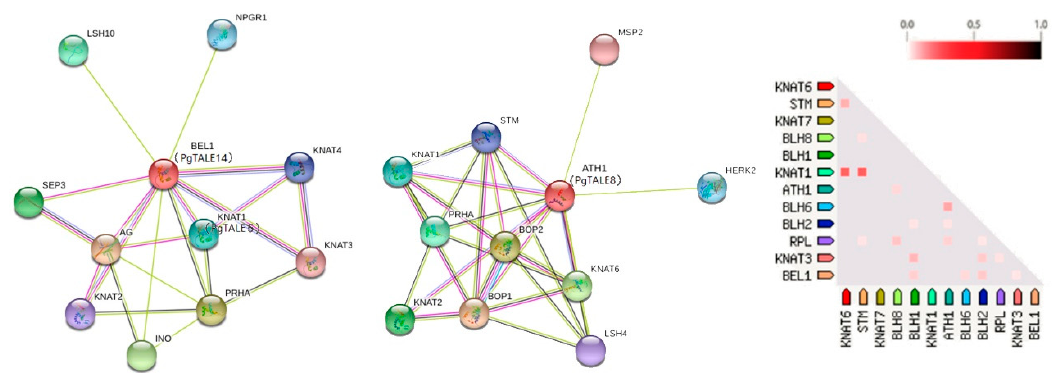
Figure 4. Protein-protein interaction network and co-expression of PgTALE proteins was analyzed by String online software.